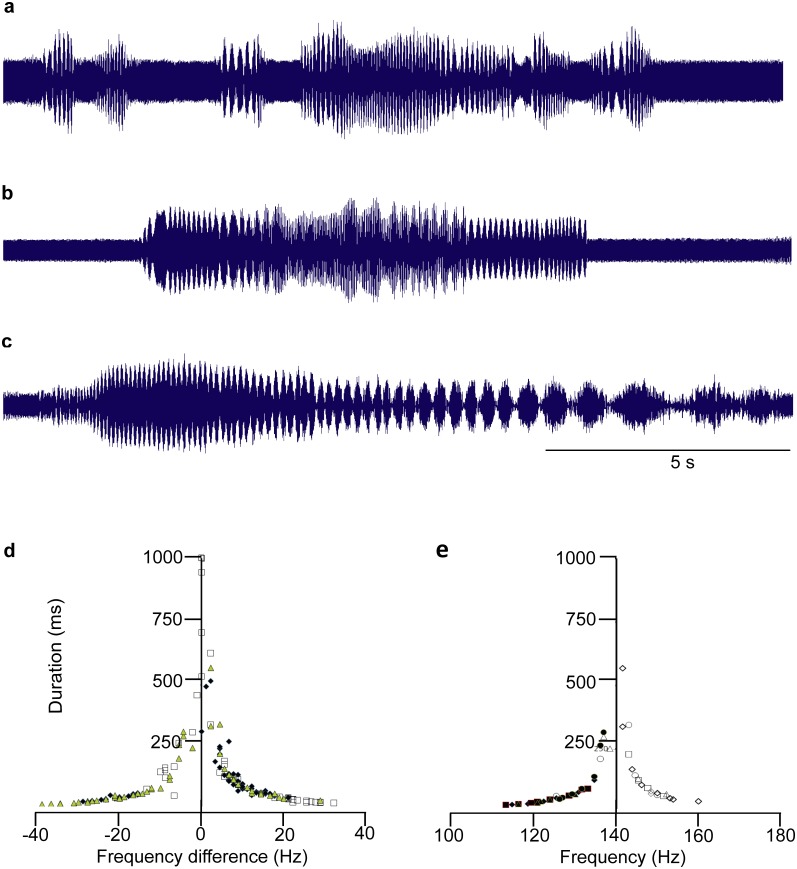
Naturally emitted FS-1 and MS-1 pulses overlapped by continuous pure tones.
The relation between interference pulse duration and the difference between MS-1 and pure tone frequencies at different frequency and velocity levels. a,b, c: naturally emitted FS-1 and MS-1 signals overlapped by (a) 100 Hz/0.69 mm/s, (b) 125 Hz/1.13 mm/s and (c) 150 Hz/0.60 mm/s pure tones. d: mean interference pulse duration (SD<40% of the mean value, N = 3–23, n = 6) of naturally emitted MS-1 signals overlapped by 100 Hz/0.22 mm/s (black diamonds), 125 Hz/0.22 mm/s (open squares) or 150 Hz/0.22 mm/s (grey triangles) pure tone vibration. Means were determined in 1000 ms sections beginning from start to end of the MS-1 signal, e: mean pulse duration (SD<40% of the mean value, N = 3–26, n = 9) of naturally emitted MS-1 signals on soybean masked by 150 Hz/0.343–1,151 mm/s pure tone vibration. Black markers: MS-2 signals with FM decreasing from a starting dominant frequency below 150 Hz; open markers: MS-2 signals with starting frequency of FM above 150 Hz. Means were determined in 1000 ms sections beginning from the start to the end of the MS-1 signal. Time bar 5 seconds.